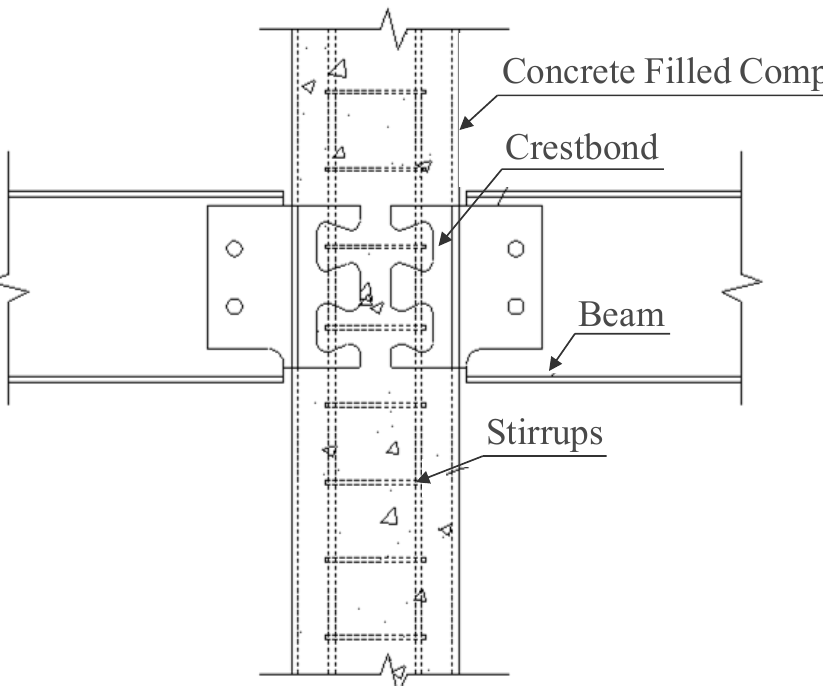
Figure 1. Crestbond shear connector as load transfer device